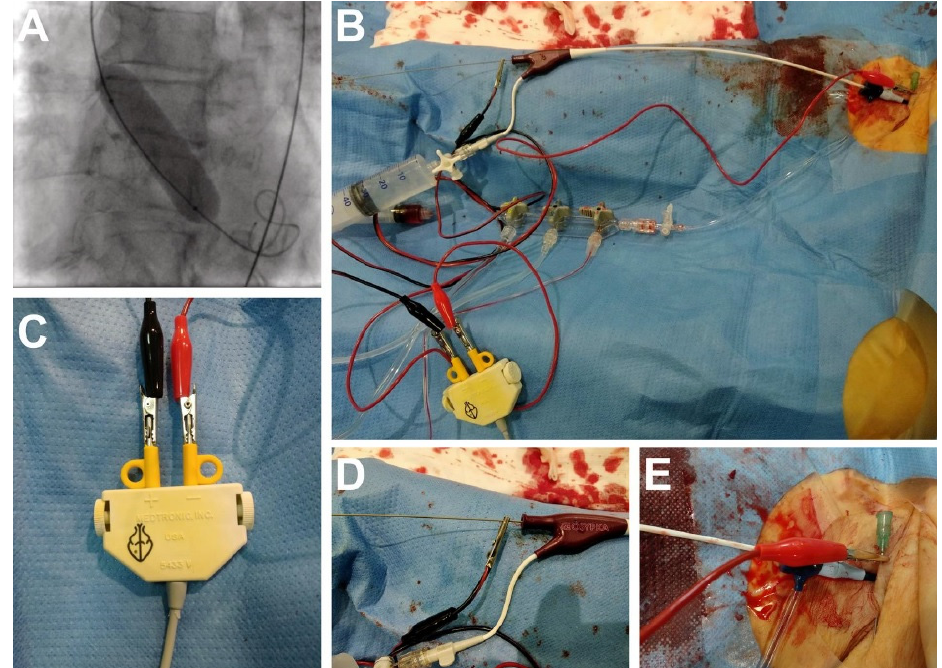
Figure 1. ( A ) Fluoroscopy of the rapid wire pacing during the balloon aortic valvuloplasty. ( B )